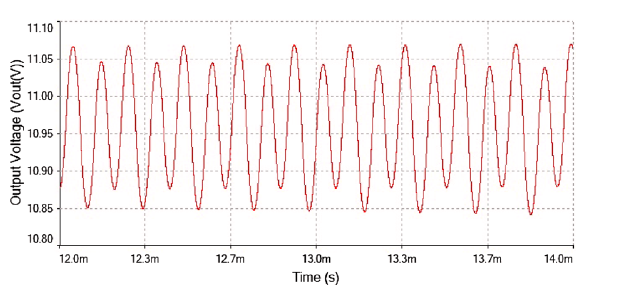
Figure 22. Output voltage waveform for forward converter at R L = 7.5 (cid:31)